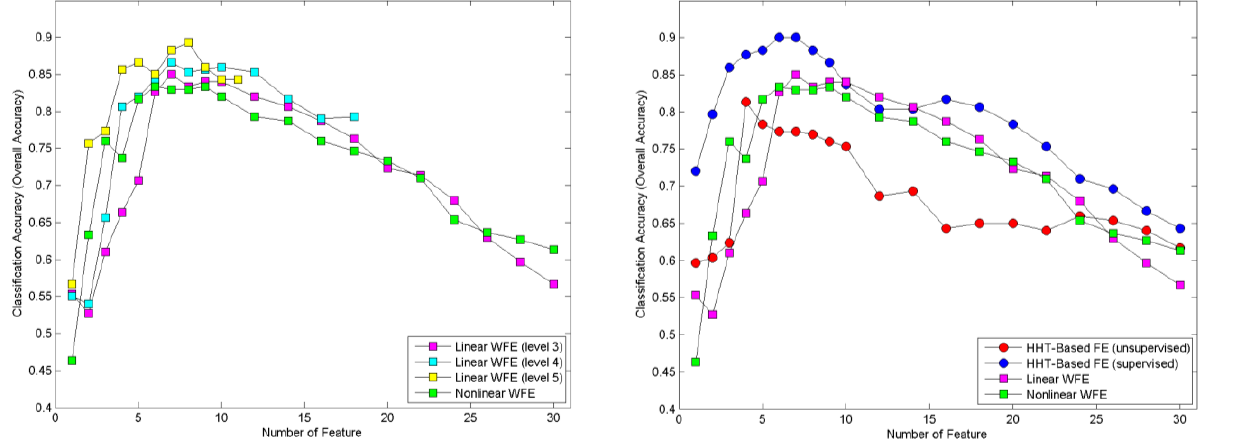
Figure 4. Comparison of classification accuracies between WFE Figure 5. Comparison of classification accuracies between methods wavelet-based and HHT-based feature extraction